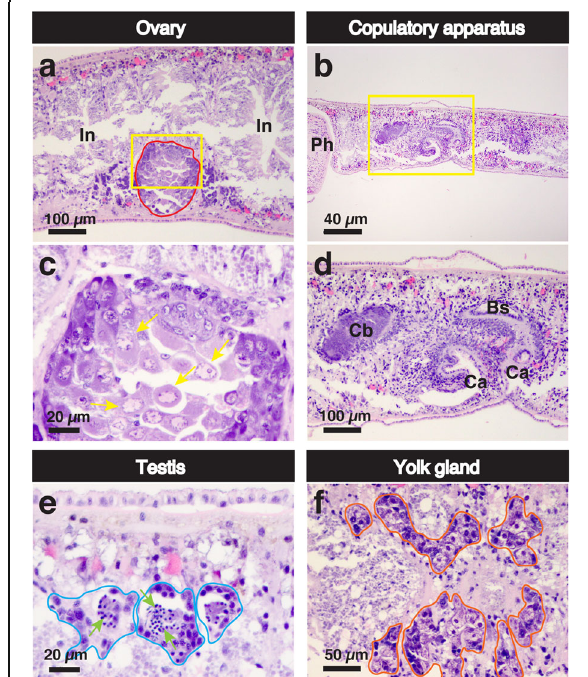
Fig. 6 Histological analysis of test worms obtained by the administration of the EtOAc layer of B. nobile. Embedded a test worm fed with about ten times the standard dose of the EtOAc layer of B. nobile was sagittally sectioned and stained with HE. The dorsal sides are at the top. a ovary, b copulatory apparatus, e testes, and f yolk glands. ( c and d ) High magnification of the area squared by the yellow line in ( a and b ), respectively. Domains bound by the red line in ( a ), the blue line in ( e ), and the orange line in ( f ) are the female germ cell masses (ovaries), the male germ cell masses (testes) and yolk glands, respectively. The cells indicated by the yellow arrow in ( c ) and green arrow in ( e ) are an oocyte and a spermatid, respectively. Ca, common antrum; Cb, copulatory bursa; Bs, bursa stalk; In, intestine; Ph,